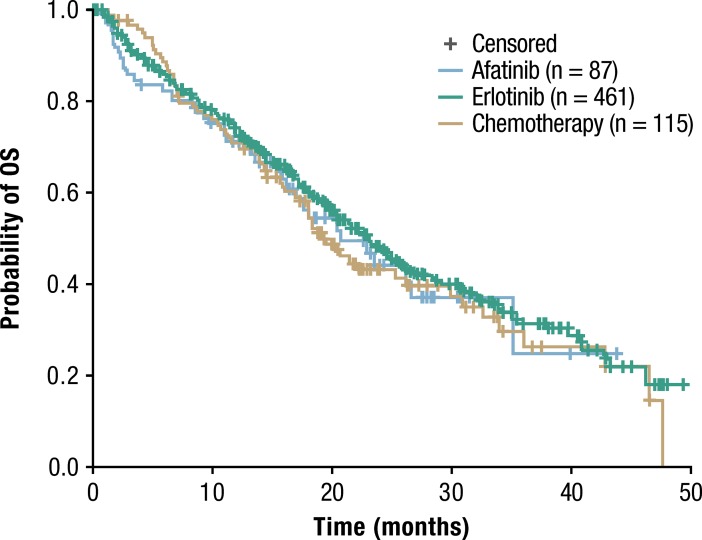
Kaplan-Meier estimates of OS stratified by treatment group in patients diagnosed after May 2013.